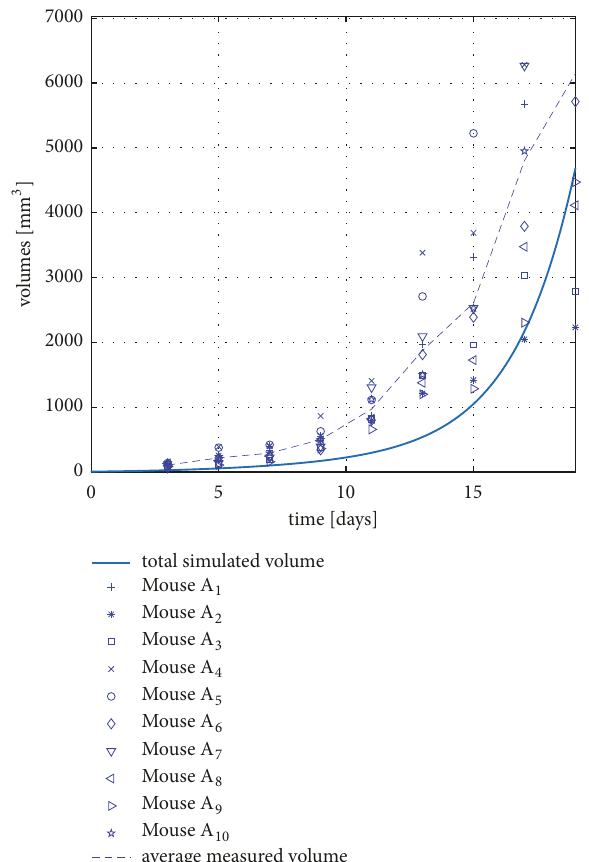
Figure 8: Measured and simulated tumor volumes in the case of no